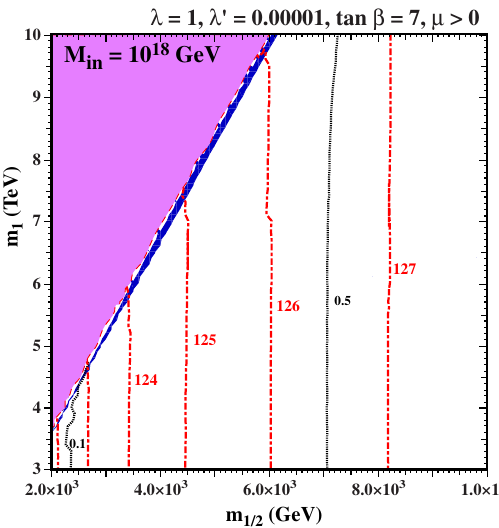
λ (cid:2) = 10 − 5 . The shadings and contour colors are the same as in Fig. 1. The width of the relic density region ( shaded blue ) has been enhanced for better visibility